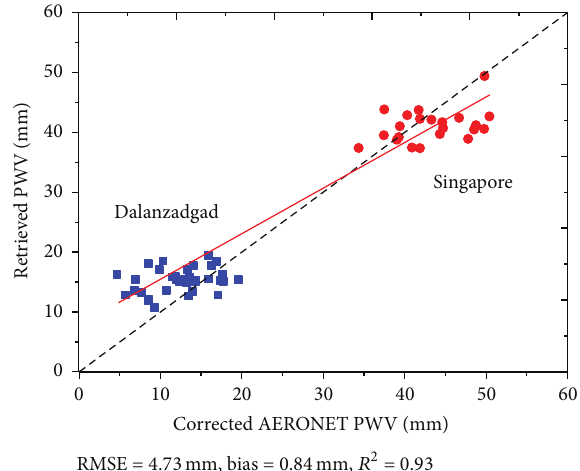
Figure 7: Comparison of the corrected AERONET PWV and the retrieved PWV for cloud-free conditions at Dalanzadgad (in dry area) and Singapore (in tropical region)